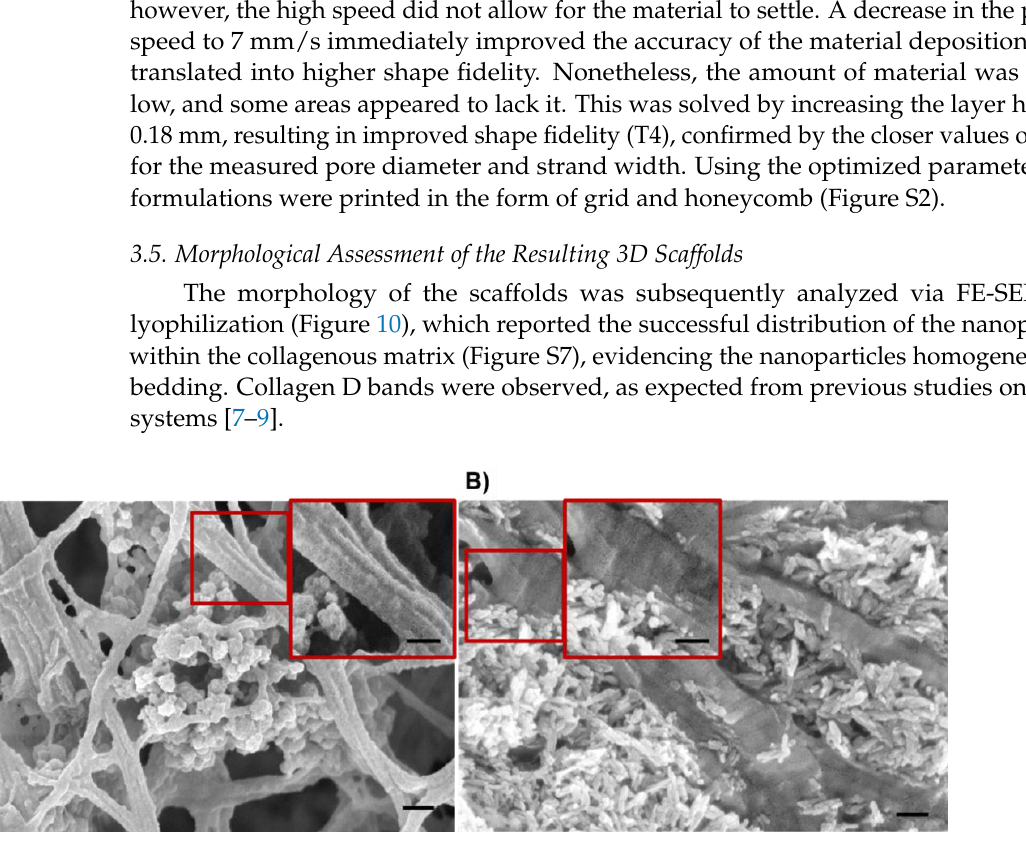
Figure 10. FE-SEM micrographs of produced scaffolds after freeze-drying. ( A ) GEN-Coll/MBG_Sr4% and ( B ) GEN- Coll/nanoHA. Collagen D bands seen in both samples and zoomed in on area delimited by the red squares. Scale bar 100 nm.